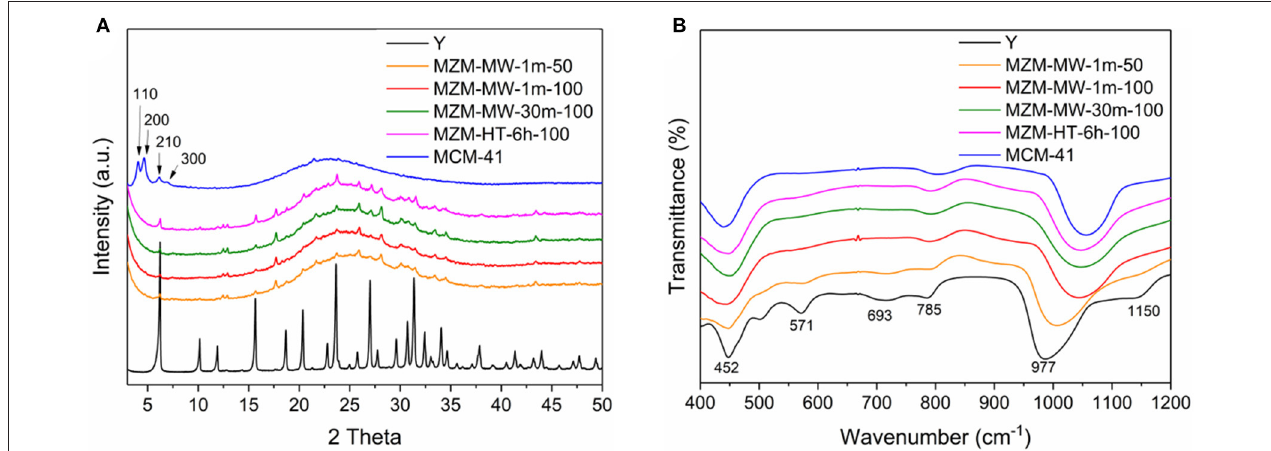
FIGURE 2 | (A) XRD patterns and (B) FT-IR spectra of the Y zeolite, MZMs, and MCM-41.